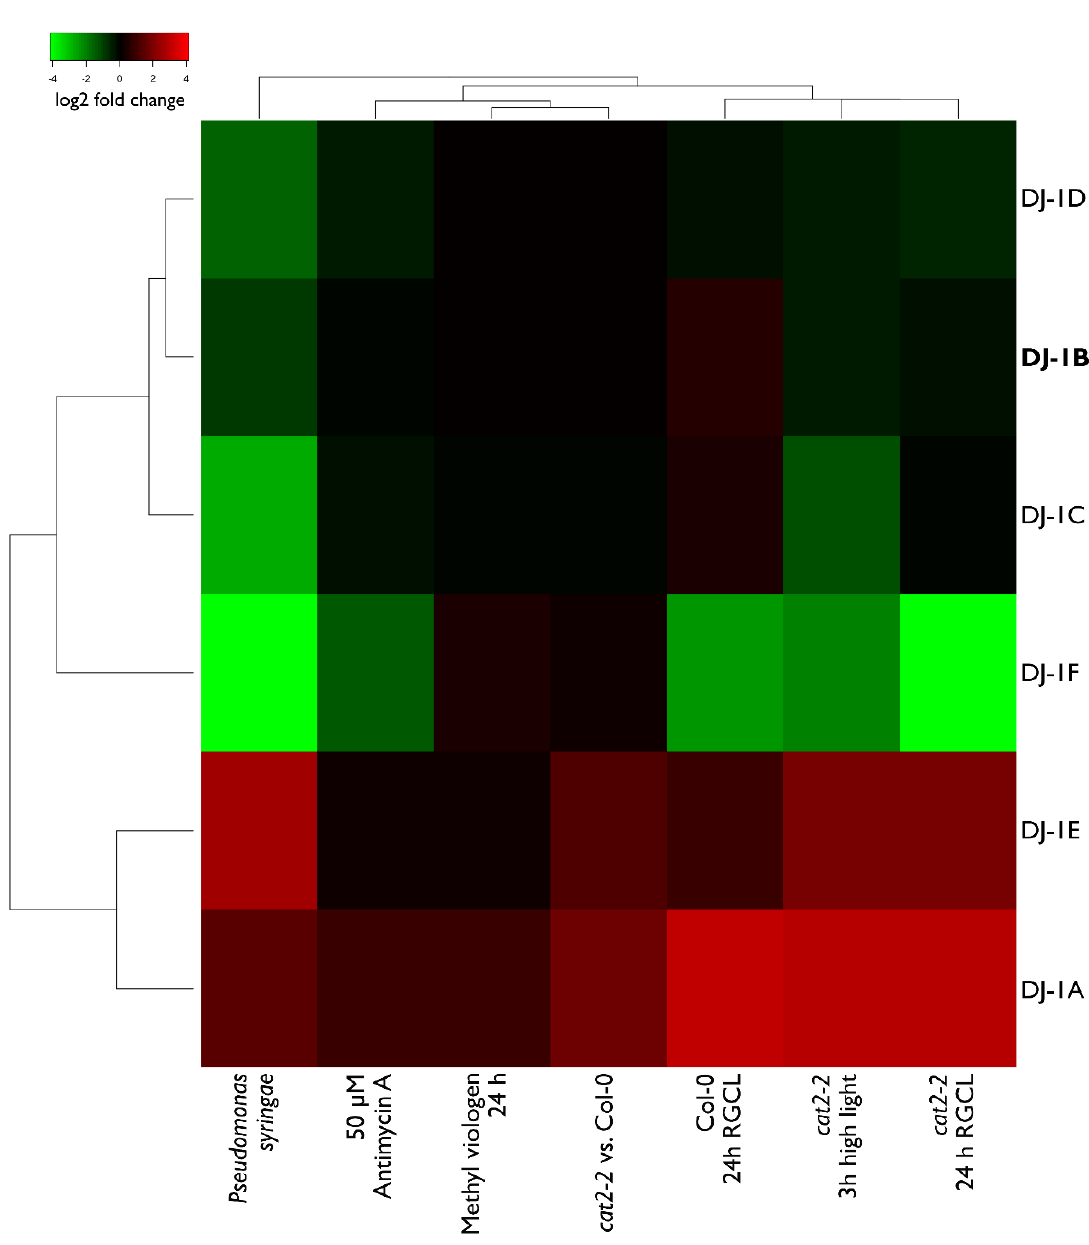
Figure 9. Arabidopsis DJ-1 gene expression levels respond differently after various stress treatments. Arabidopsis plants were either treated by a stress agent (pathogen Pseudomonas syringage , methyl viologen, high light, RGCL—Restricted Gas Continuous Light—treatment [29], or two lines (Col-0 and cat2-2 ) were compared to each other. The RNASeq experiments from which the data was obtained, as well as the detailed descriptions of the treatments are referred to in Materials and Methods. Colors represent log2 fold change.